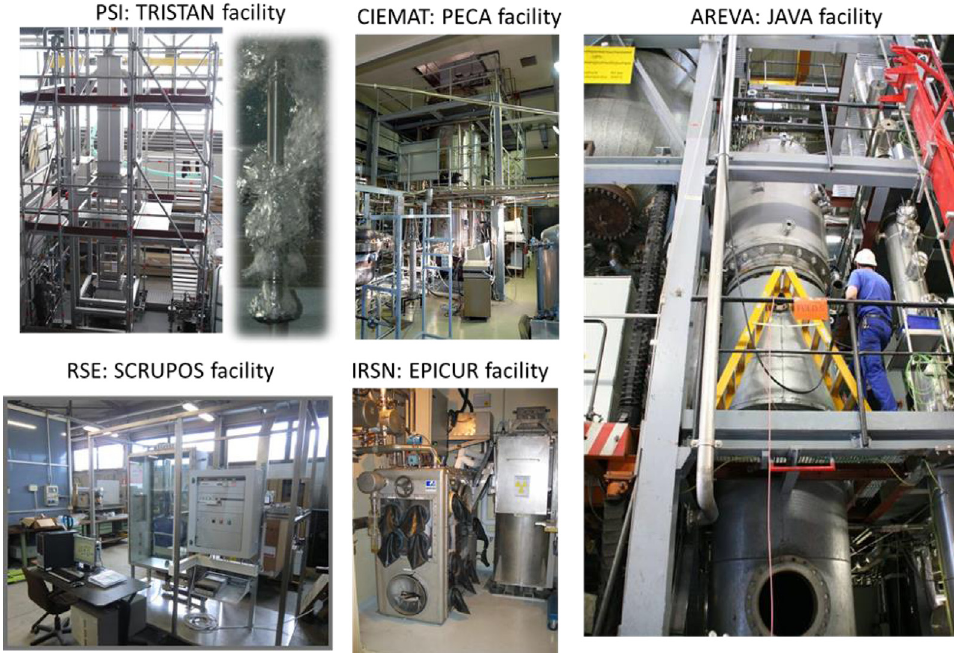
Fig. 5. Some selected PASSAM experimental facilities ( © PASSAM,